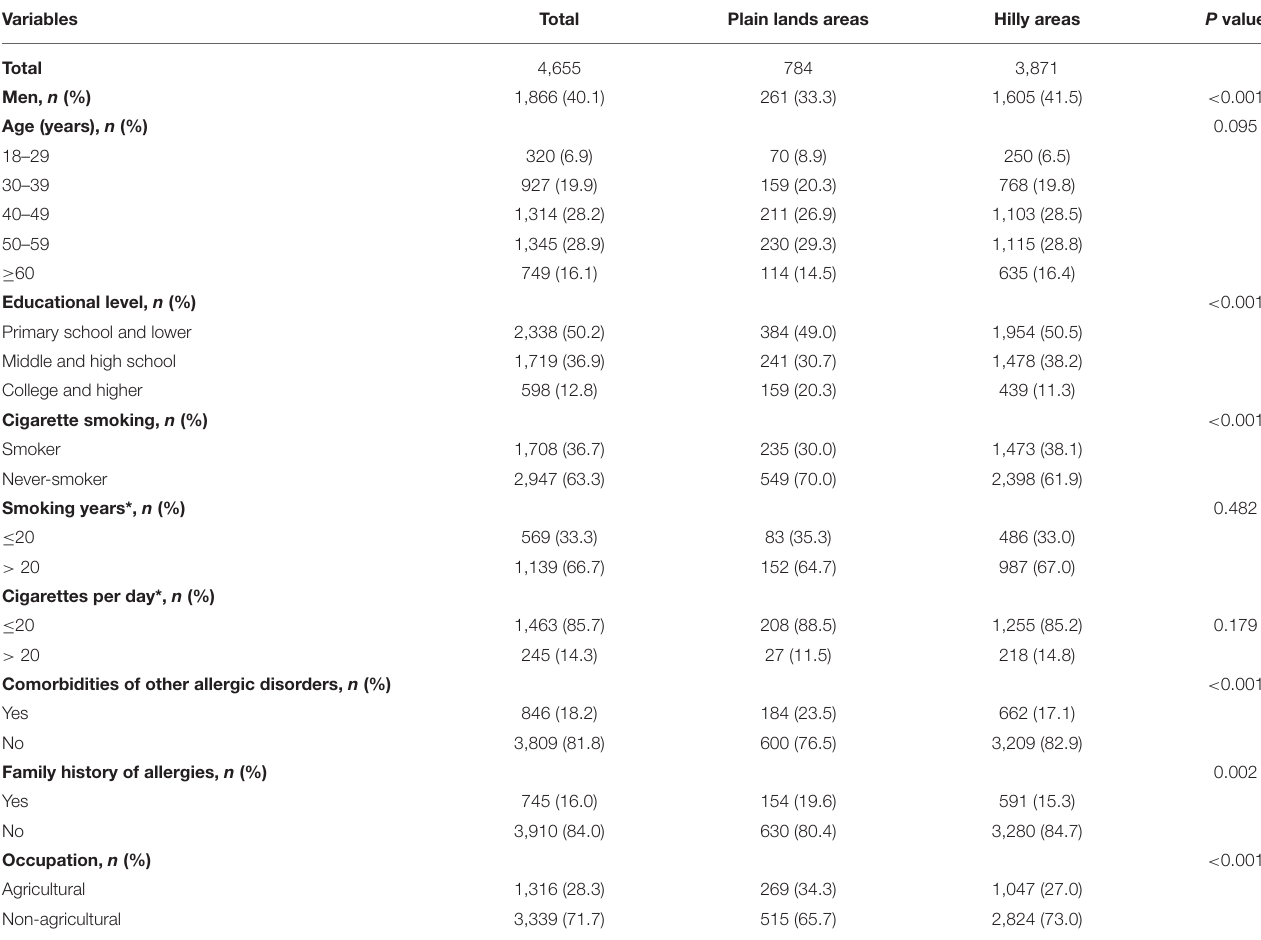
TABLE 1 | Demographic characteristics of the